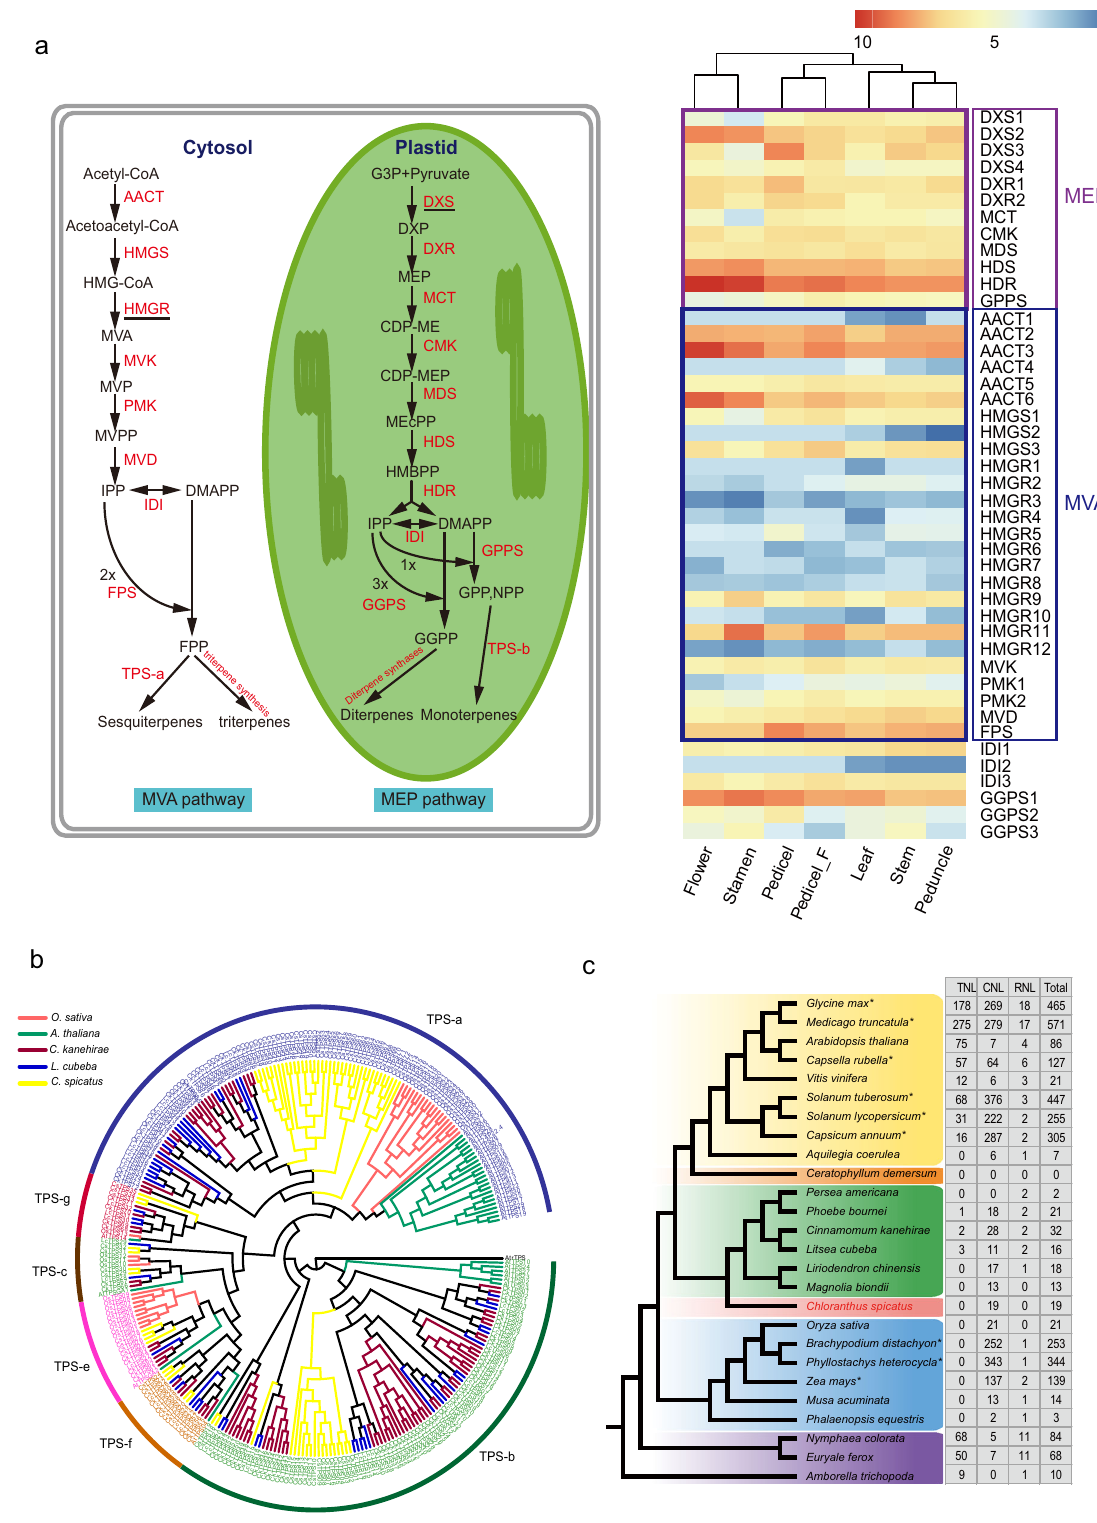
encompass more than 80% of the characterized R genes 40 . The NBS genes were divided into three classes, namely, TIR-NBS-LRR (TNL), CC-NBS-LRR (CNL), and RPW8-NBS-LRR (RNL) 40 . We identi fi ed 3,518 nucleotide-binding site-leucine-rich repeats (NBS-LRR, NBS for short) genes in 28 angiosperm species, and the nucleotide-binding site-leucine-rich repeat (NBS-LRR) genes were classi fi ed into three classes: the Toll/interleukin-1 receptor